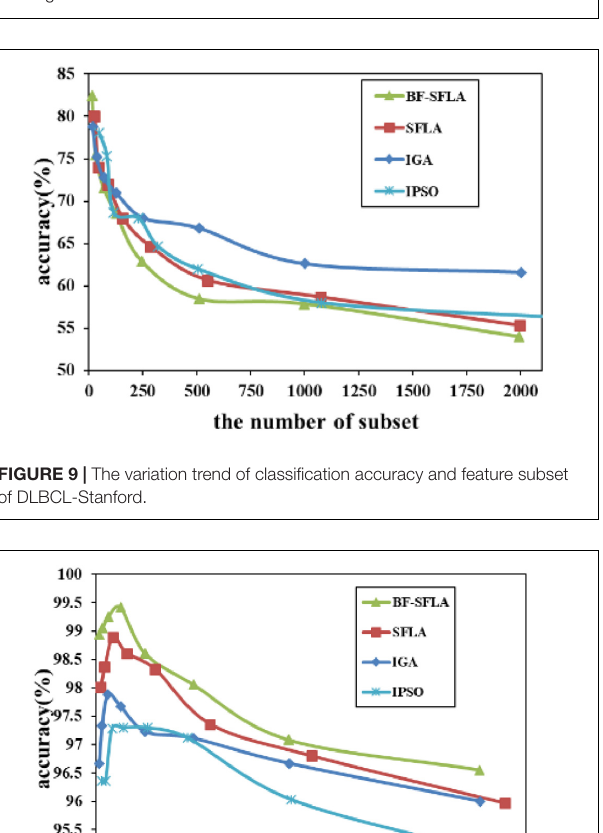
FIGURE 5 | The variation trend of classification accuracy and feature subset of ColonTumor.